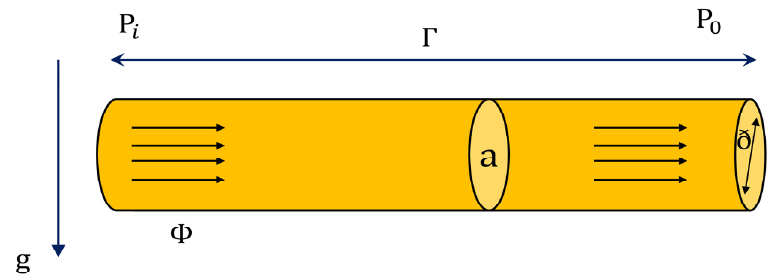
Figure 1. The suggested pipeline architecture.